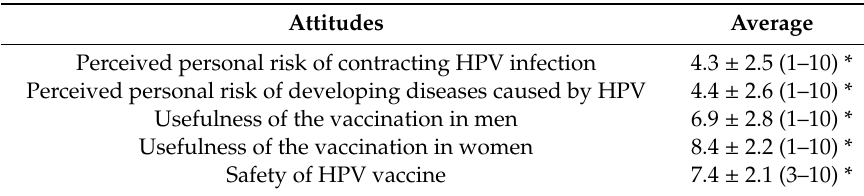
Table 4. Attitudes regarding HPV infection and its